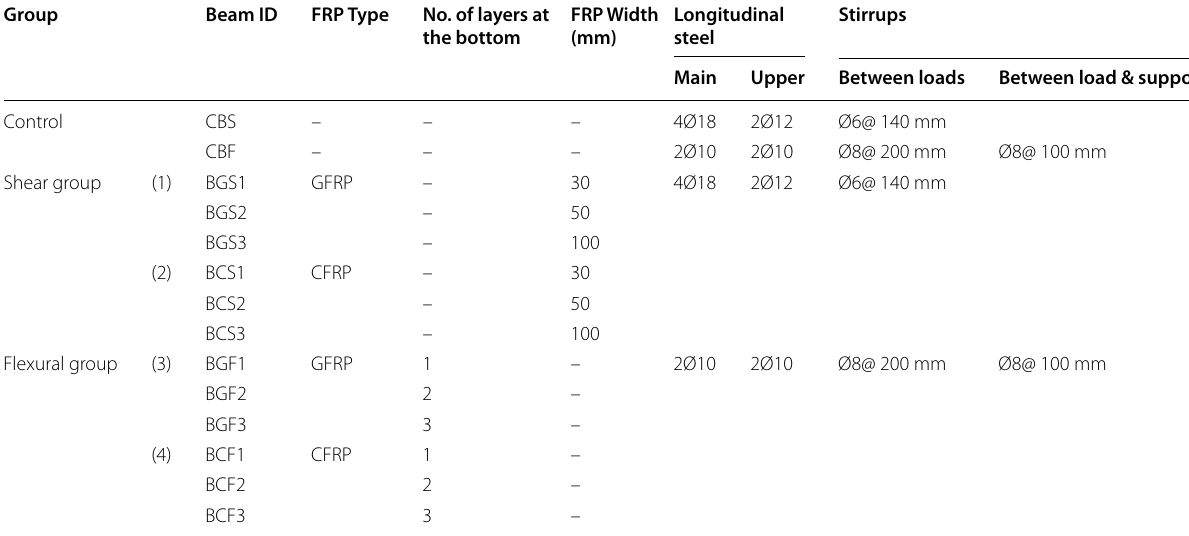
Table 1 Details of beam